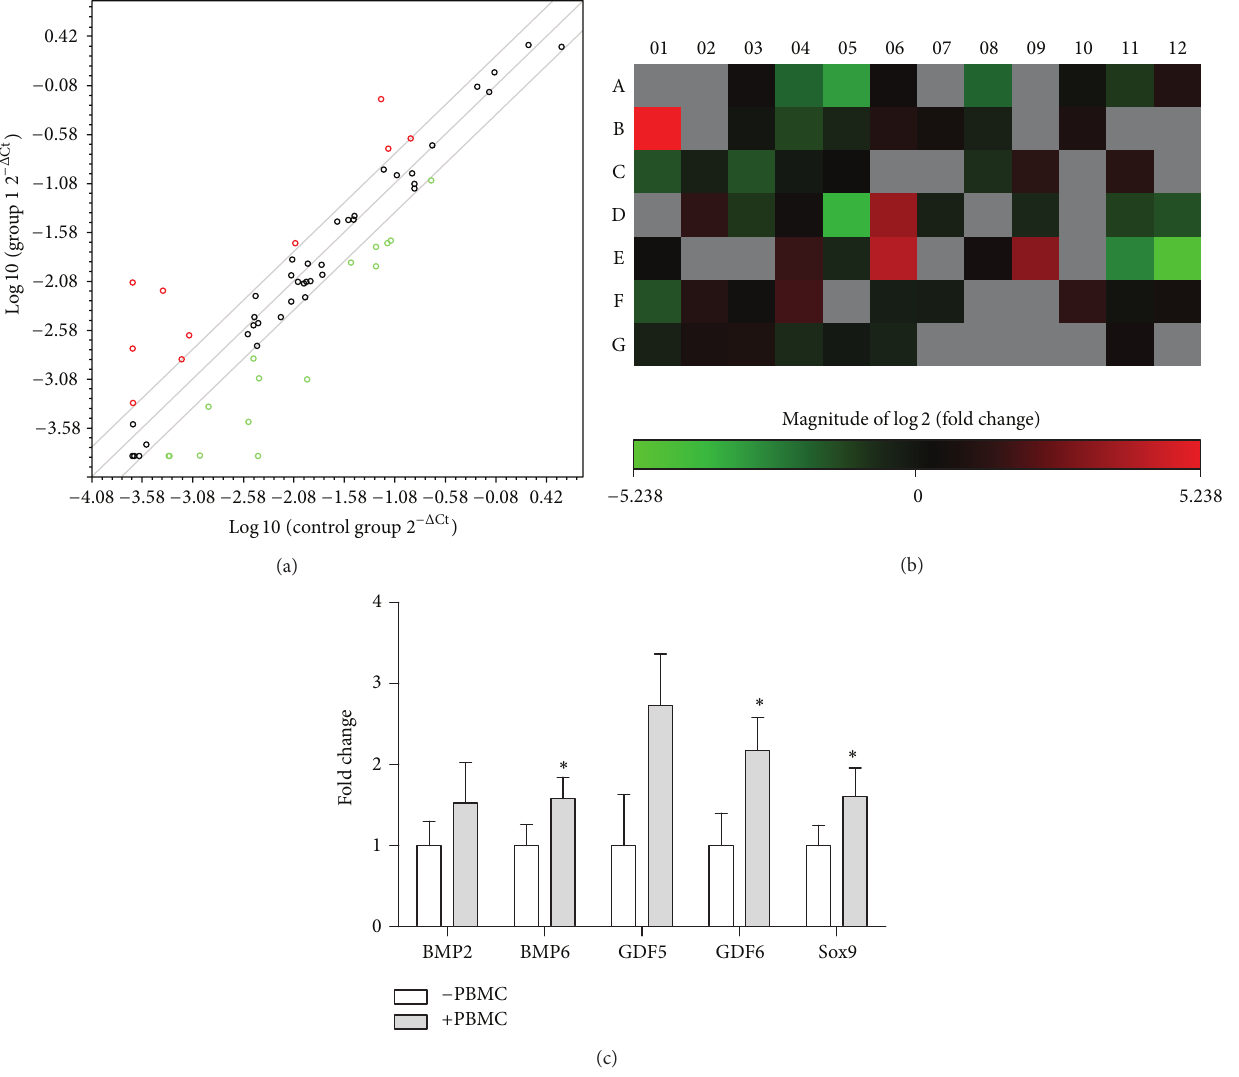
Figure 3: Change in mRNA levels after 24h PBMC stimulation with a cut-off value of 4. (a) A scatter plot showing up- and downregulated genes and core genes with no change ( 𝑛 = 1 ). (b) A heat map visualization of 2log2-fold change of the 84 genes in the stem cell PCR array (red: upregulated and green: downregulated). Grey shows the genes that were undetermined (no Ct value with a cut-off value of 35). (c) Real-time PCR validation of 5 key chondrogenic genes ( 𝑛 = 4 ) normalized to B2M housekeeping gene mRNA